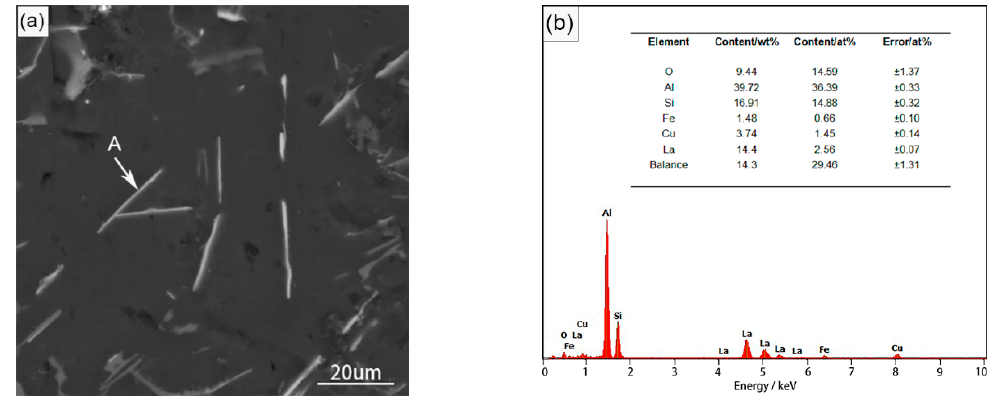
Figure 3. Scanning electron microscope (SEM) micrograph of ( a ) AlSi5Cu1Mg + 0.6 wt % La alloy and ( b ) energy dispersive spectrum (EDS) analysis of region A in ( a ).